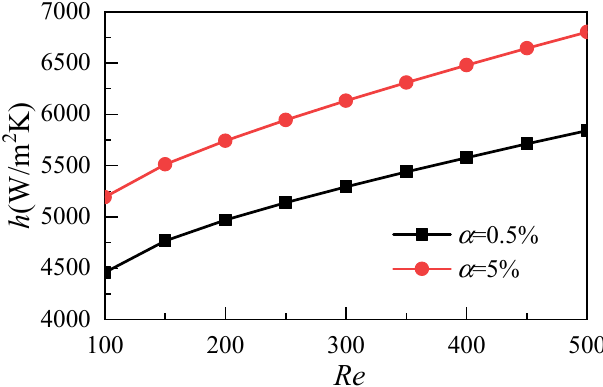
Figure 4. Average temperature distributions of the fluid-solid surface.